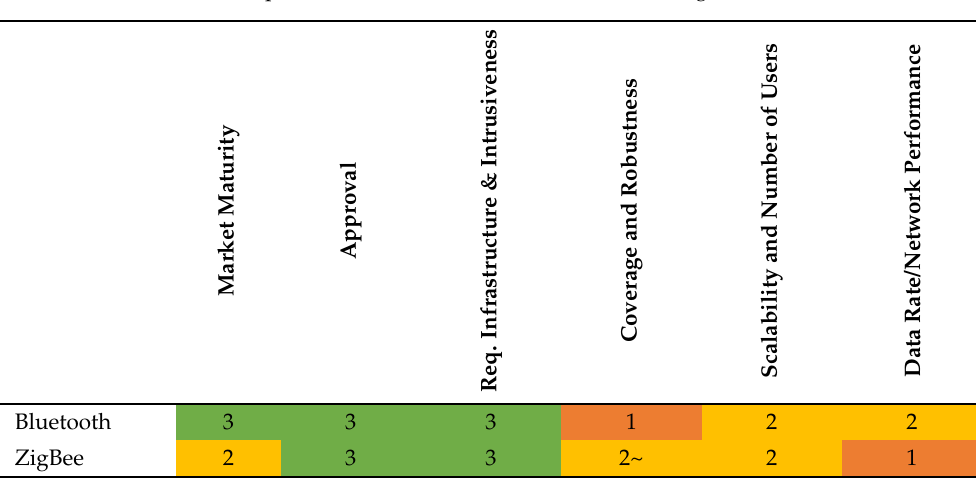
Table 2. Summarized Comparison and Evaluation of Bluetooth and